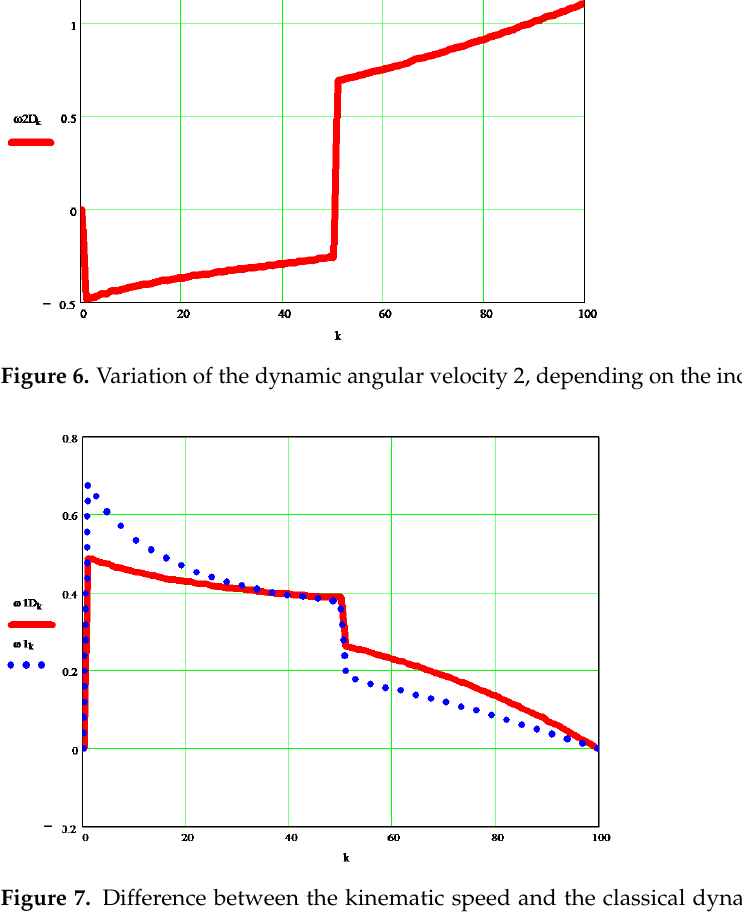
Figure 7. Difference between the kinematic speed and the classical dynamic speedof the mobile element 1 of the robot.